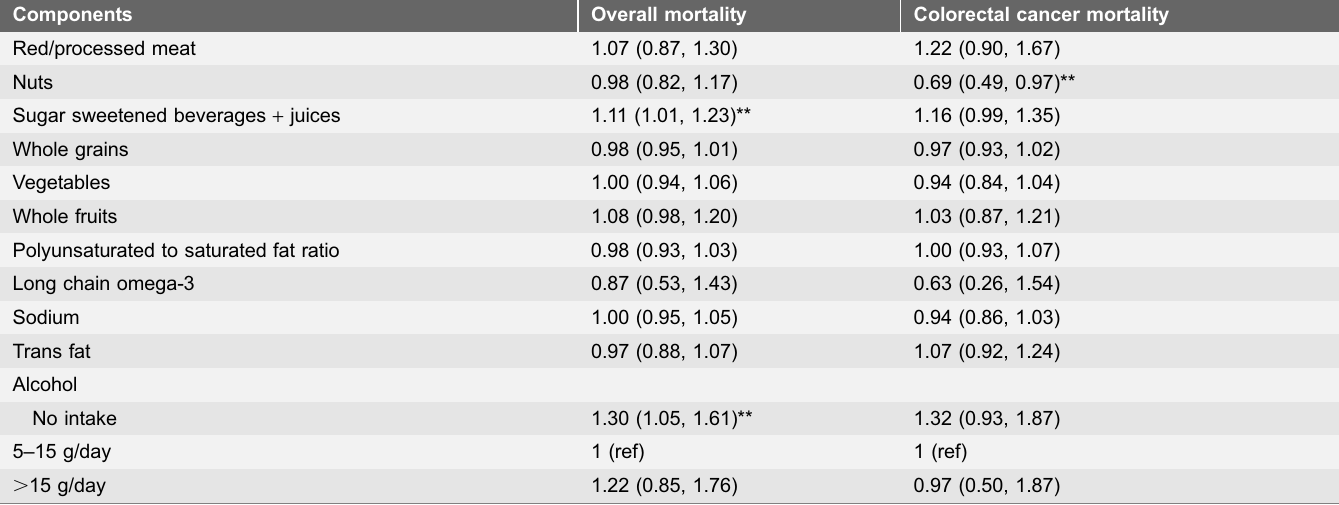
Table 4. Multivariable* hazard ratio (95% CI) of AHEI-2010 components (per serving per day unless otherwise specified) for mortality in NHS